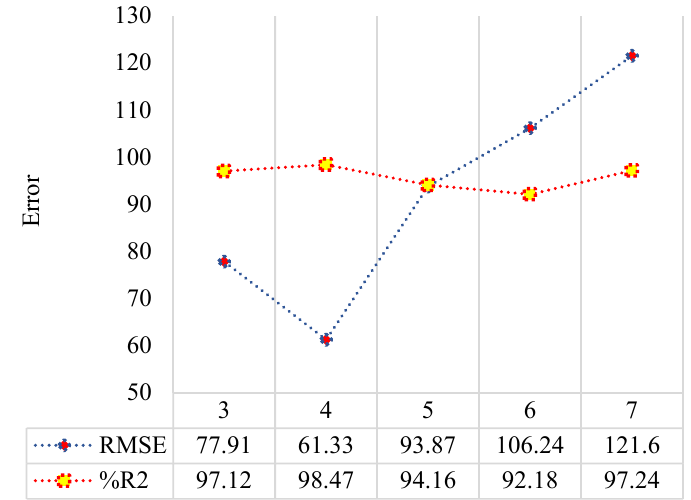
Figure 6. Performance of DmGNn for different numbers of neurons (A: R 2 statistic for the different number of DmGNn neurons; B: RMSE statistic for the different number of DmGNn neurons).